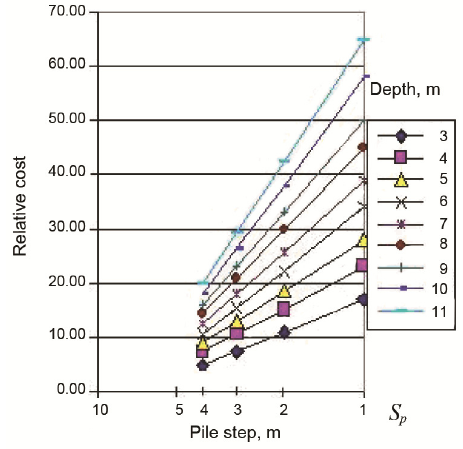
Fig. 8. Piles (with pre-fabricated caps)